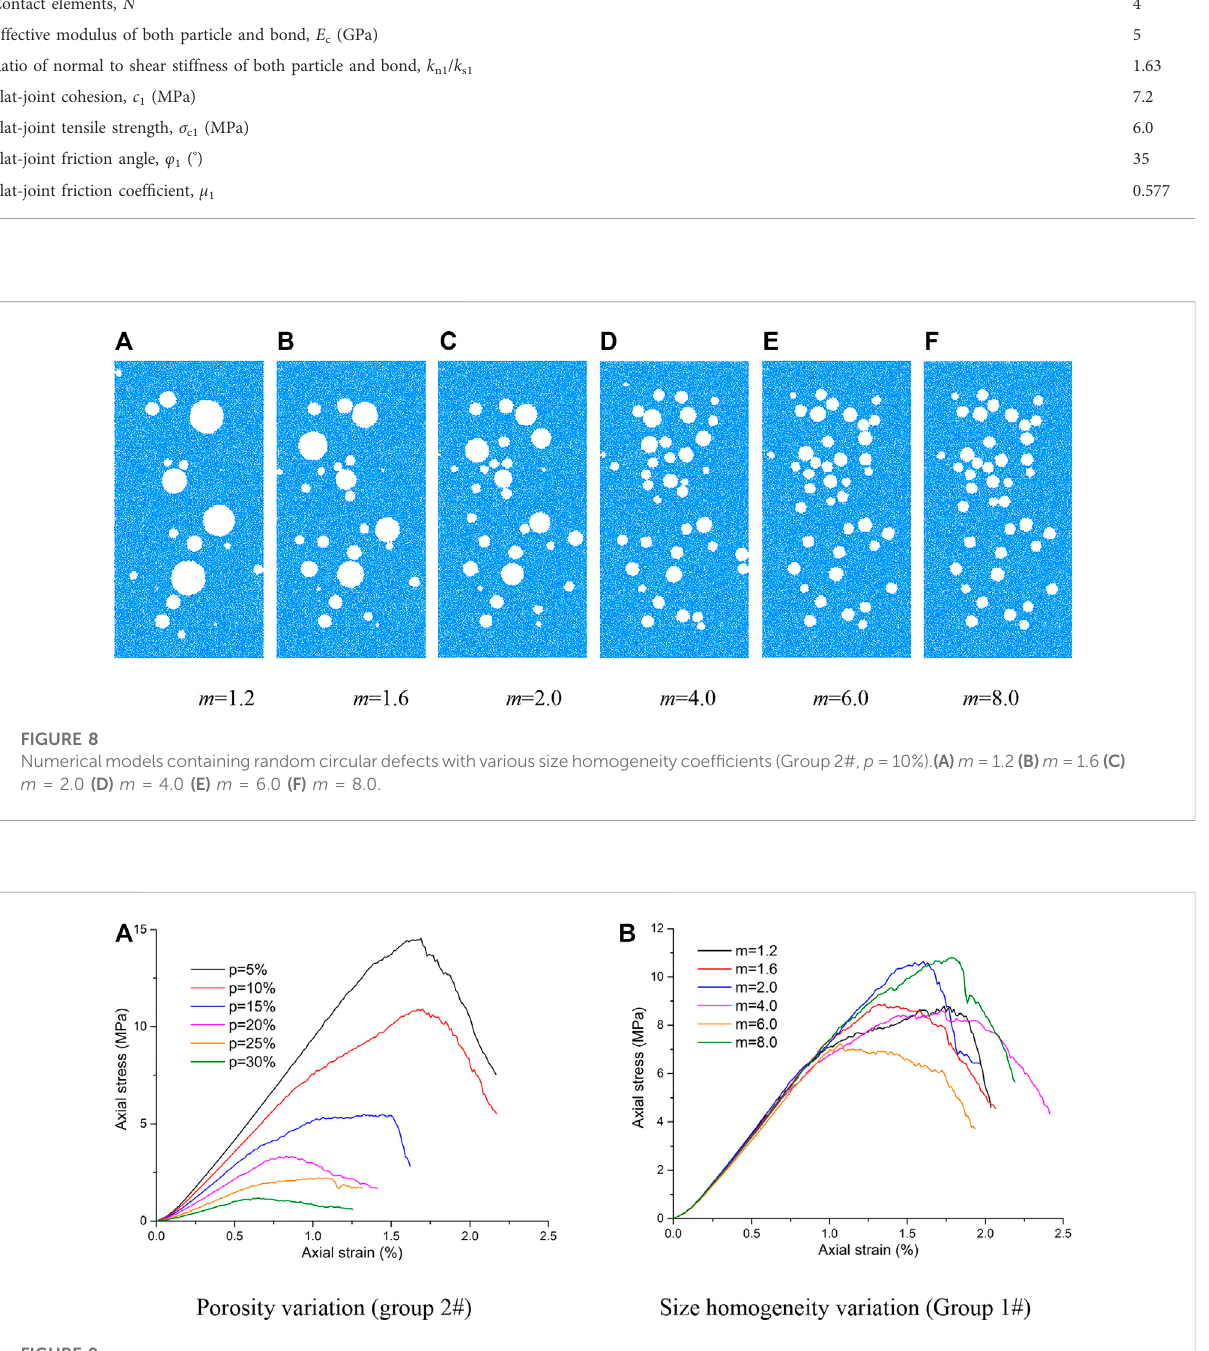
Stress-strain curves of the models containing random circular defects. (A) Porosity variation (group 2 # ) (B) Size homogeneity variation (Group 1 #